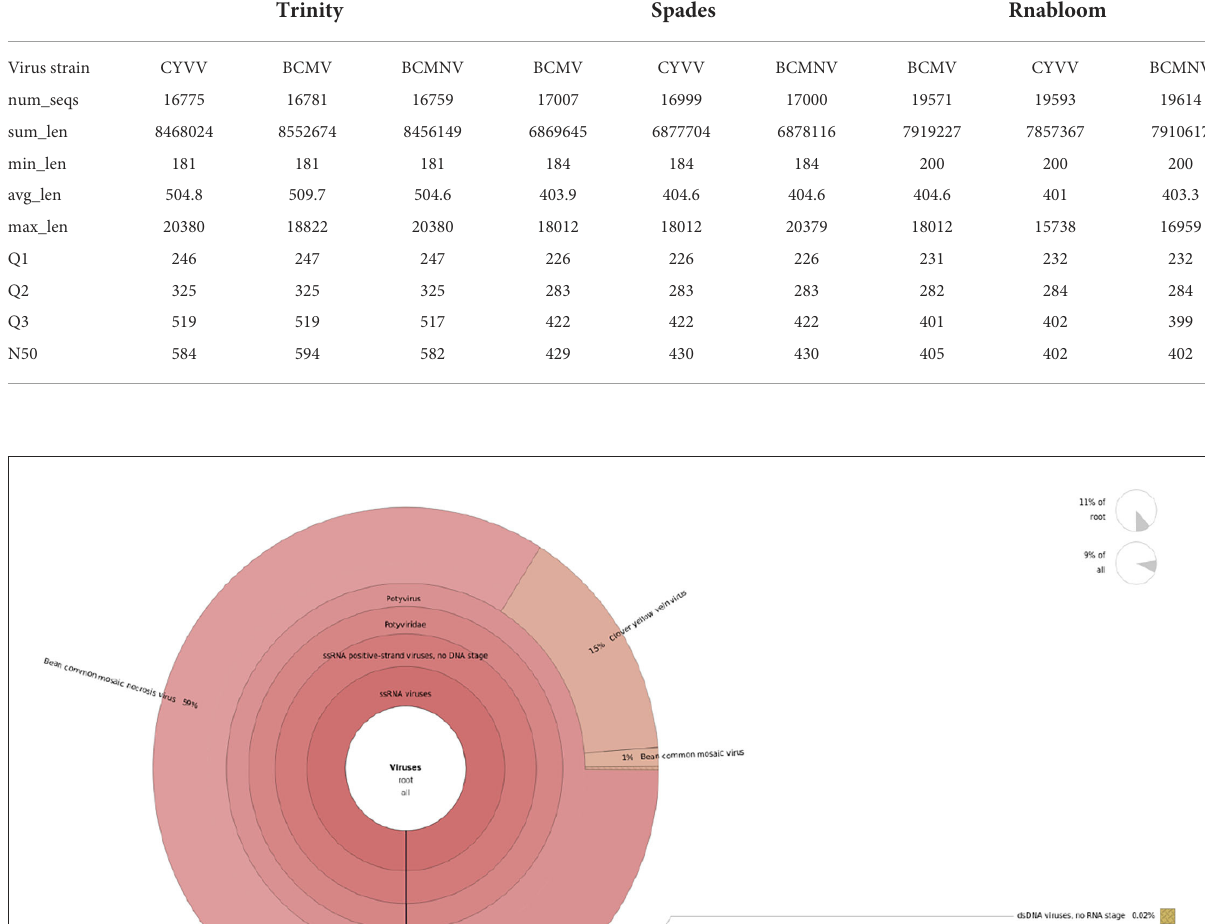
TABLE 1 Descriptive statistics of assembled viral reads.